Question: Briefly state, in one sentence, what is plotted here.
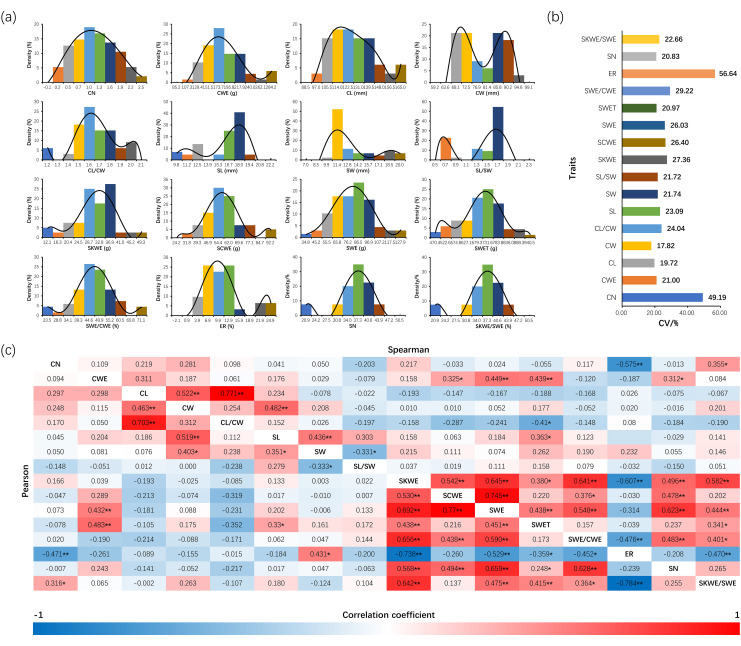
Answer: Results of phenotypic trait analysis. (a) Distribution test of phenotypic values for each trait; (b) analysis of differences and variations among traits; **extremely significant differences among clones (P<0.01). (c) correlation analysis of traits. *Significant correlation between traits (P<0.05), **extremely significant correlation between traits (P<0.01).